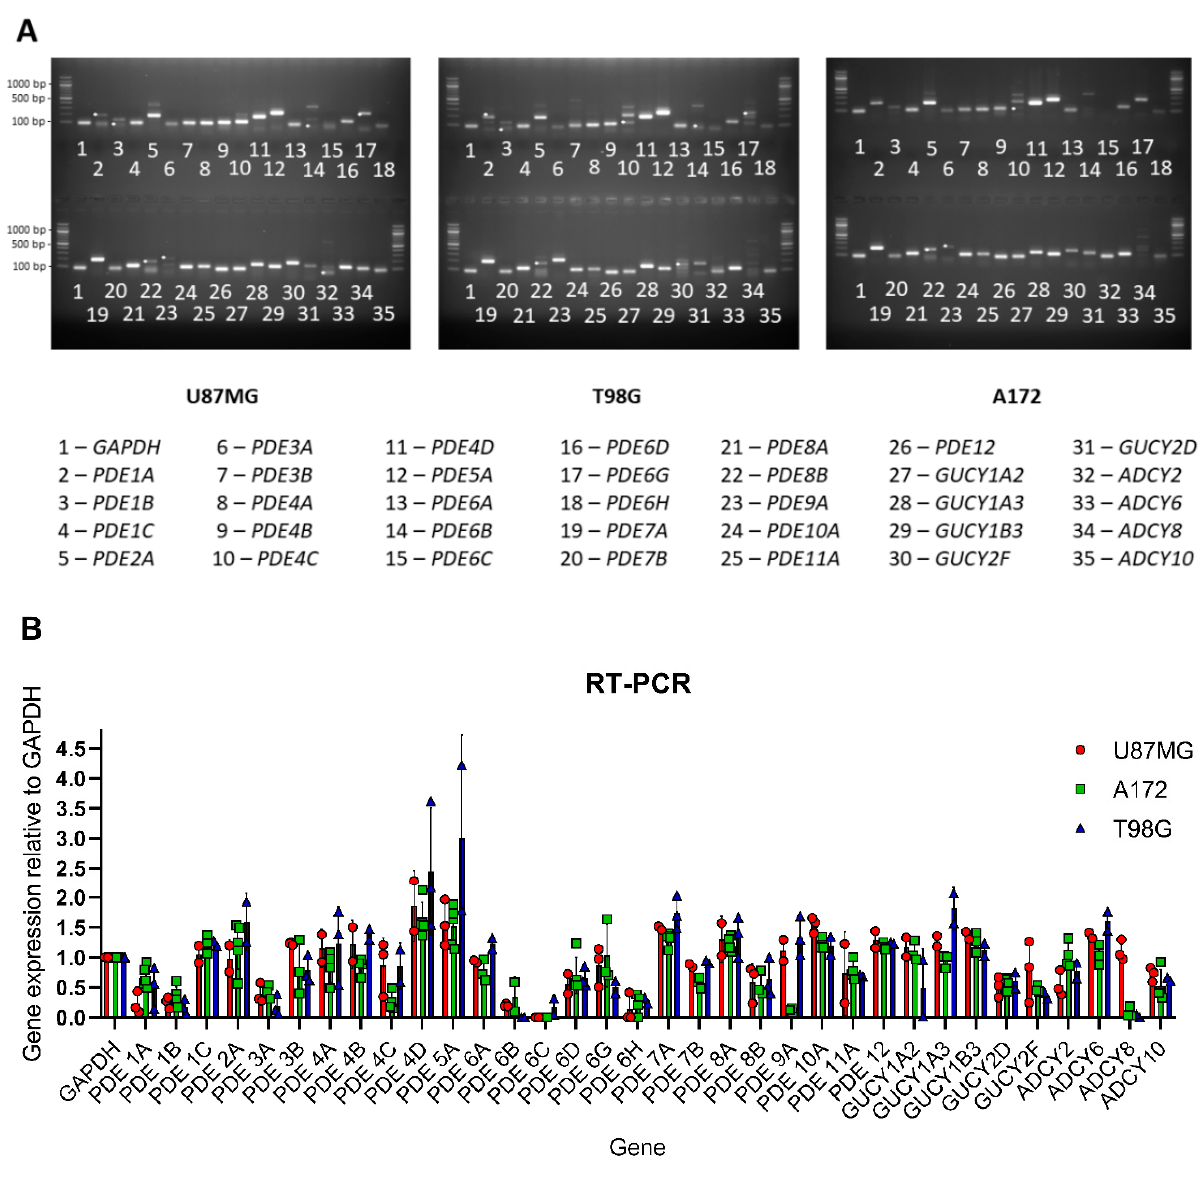
Figure 2. Relative expression levels of genes encoding PDEs, adenylyl cyclases and guanylyl cyclases in the U87MG, A172 and T98G glioblastoma cells. ( A ) Representative gels illustrating mRNA expression levels in each of the three glioblastoma lines tested. White asterisk ( * ) on the gel indicates the band of the correct size. ( B ) mRNA expression levels normalised by the GAPDH mRNA signal in glioblastoma cells grown to maximal confluence. Data are presented as the mean ± standard deviation of three independent experiments.